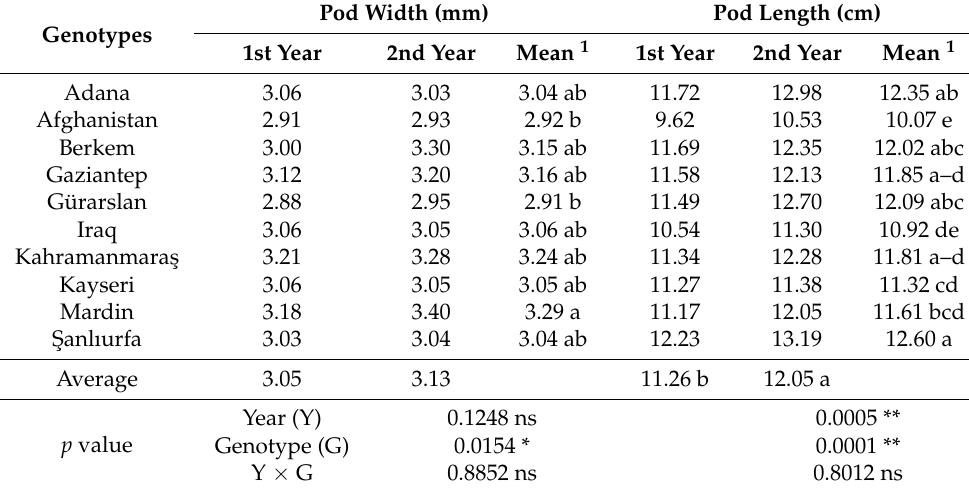
Table 4. Average values for pod width and pod length of fenugreek